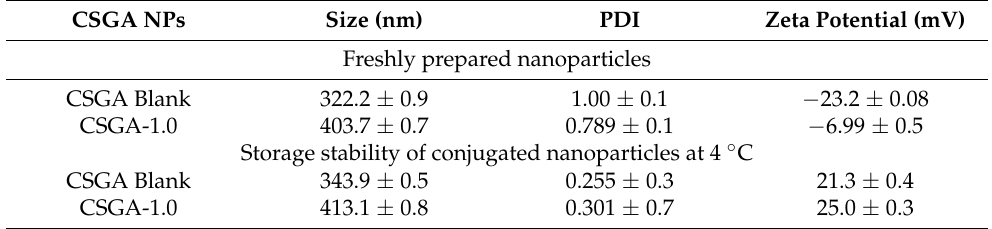
Table 1. CSGA NP size, PDI, and zeta potential at native pH; freshly prepared, and their storage stability after 20 days in DDW at 4 ◦